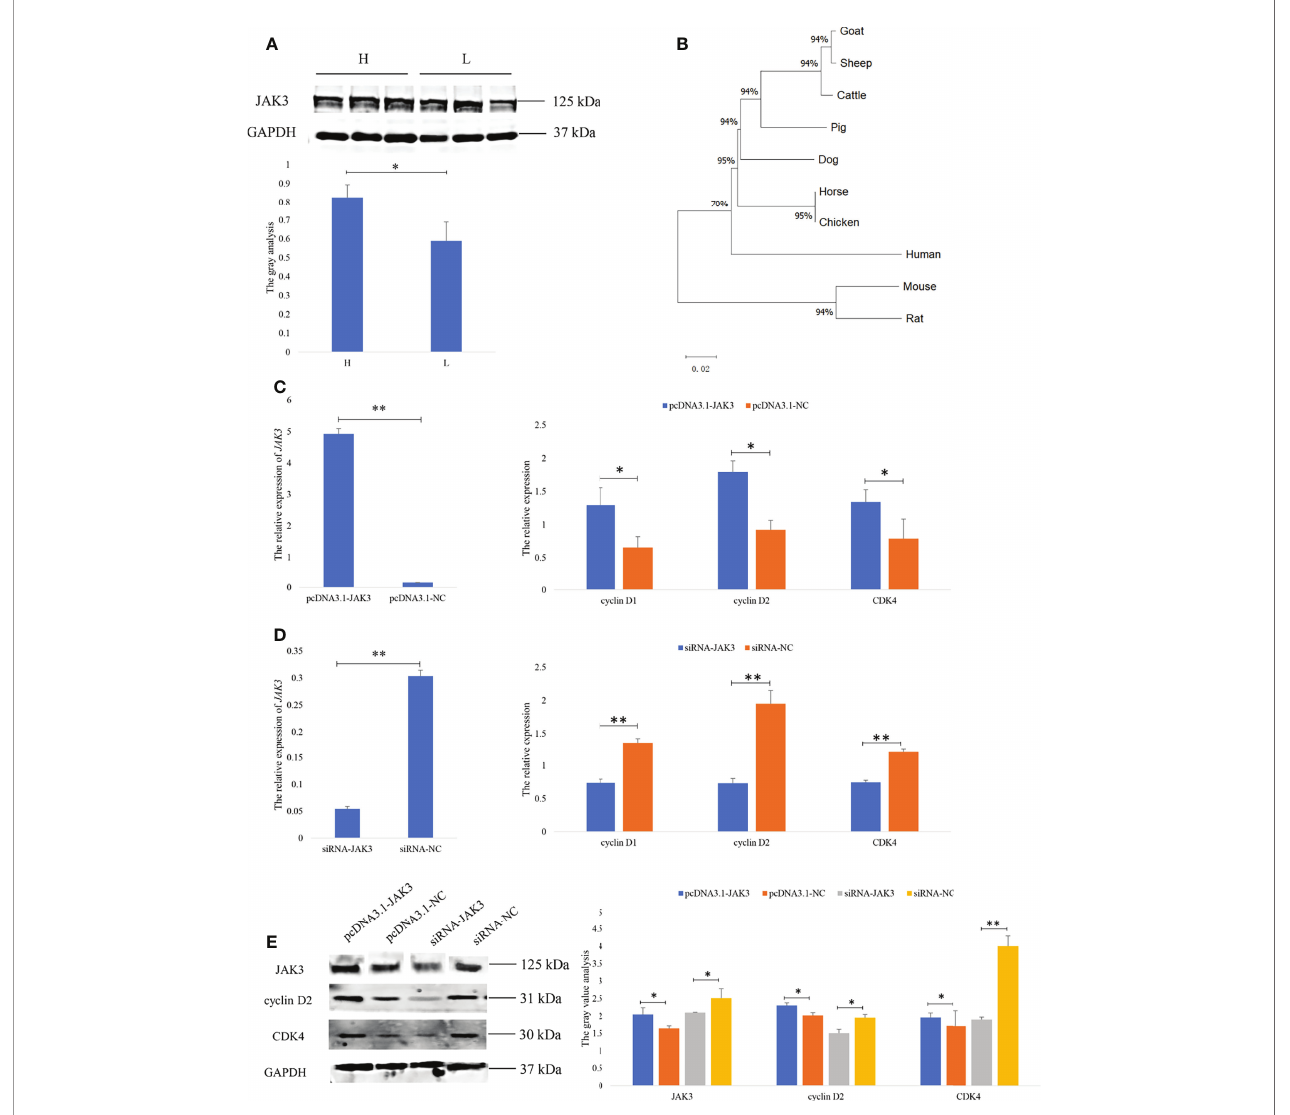
FIGURE 5 | JAK3 promoted the granulosa cell proliferation. (A) The protein of JAK3 in goat ovary. H represents the high-proli fi cacy goats; L represents the lowproli fi cacy goats. (B) The phylogenetic tree analysis of JAK3. (C, D) The mRNA expressions of JAK3, cyclin D1, cyclin D2, and CDK4 in granulosa cells transfected with pcDNA3.1- JAK3/pcDNA3.1-NC or siRNA-JAK3/siRNA-NC for 48 h are quanti fi ed using RT-qPCR. RPL19 is used as an internal control. (E) The protein expressions of JAK3, cyclin D2, and CDK4 in granulosa cells transfected with pcDNA3.1-JAK3/pcDNA3.1-NC or siRNA-JAK3/siRNA-NC for 48 h are quanti fi ed using WB. GAPDH is used as an internal control. Values are expressed as mean ± SD of n = 3. *p < 0.05, **p <